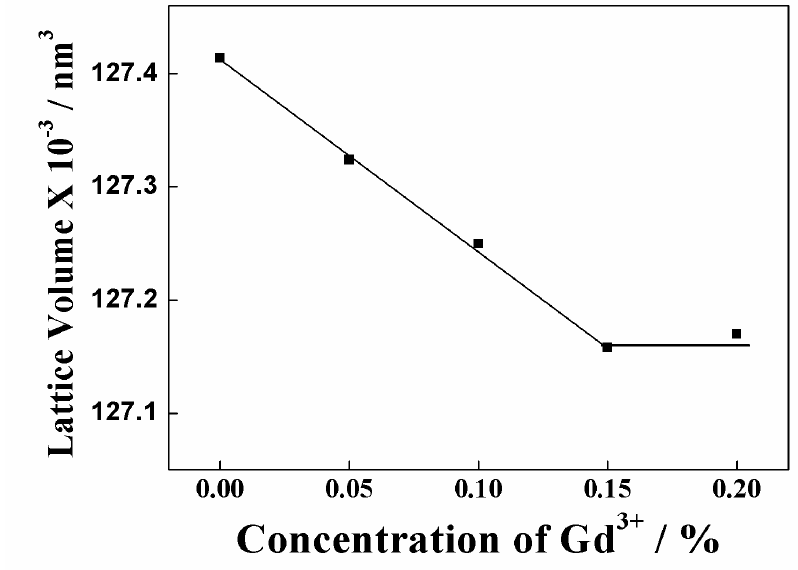
Figure 3. Dependence of the lattice volume on the concentration of Gd 3+ in the (La Gd )OBr:5%Tb 3+ (0 ≤ x ≤ 0.2) x x